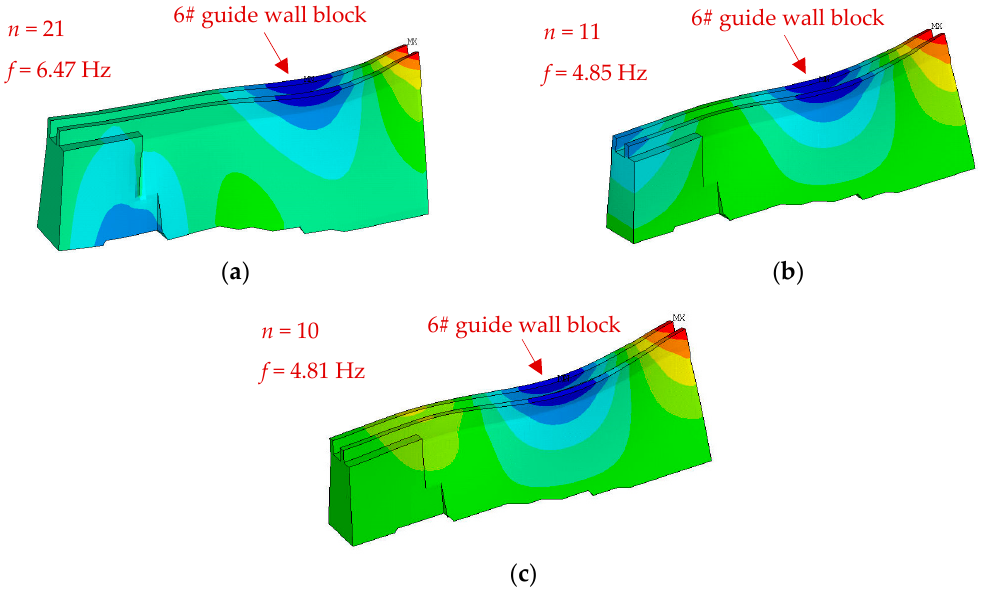
Figure 20. Vibrational modes which are in accordance with actual vibrational characteristics. ( a ) The associated vibration (AV) system; ( b ) the independent forced vibration (FV) system; ( c ) the associated-forced coupled vibration (AFCV) system.